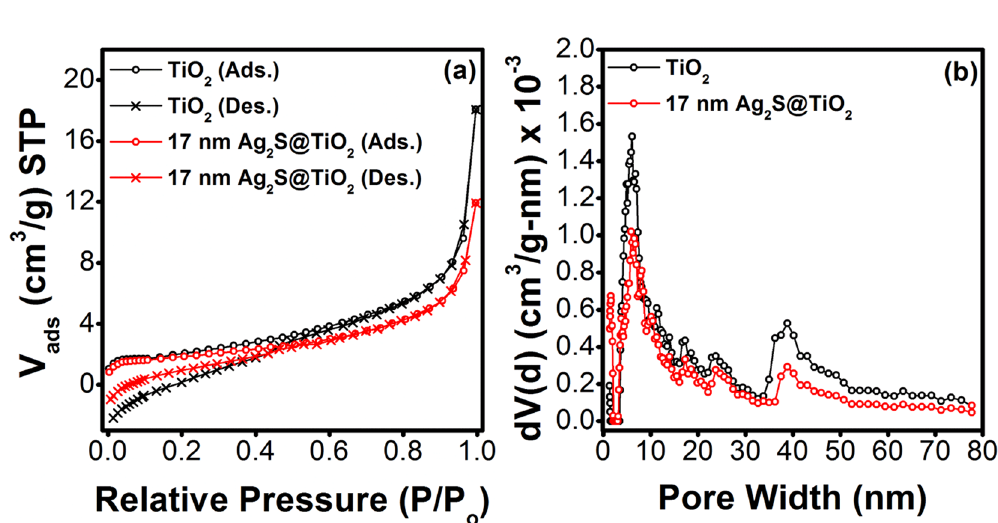
Figure 4. ( a ) Nitrogen adsorption/desorption isotherms for pure TiO 2 NFs and 17 nm-Ag 2 S@TiO 2 composite nanofibers, and ( b ) the corresponding pore size